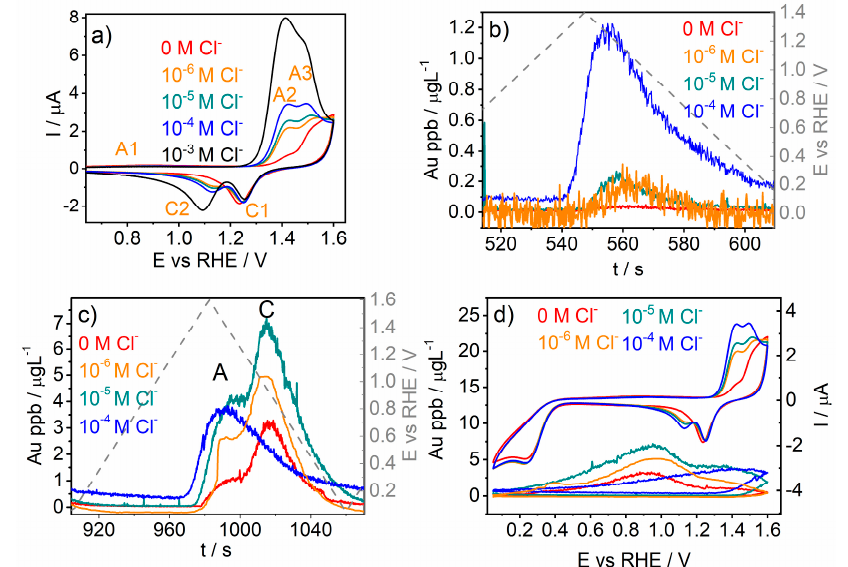
Figure 3. EFC-ICP-MS measurements of Au dissolution from Au polycrystalline disk in the absence ( a , b ) and presence of chlorides ( c , d ) during potentiodynamic cycles (20 mV·s − 1 , 0.05–1.4 or 1.6 V RHE ); ( d ) Simultaneous presentation of Au dissolution profile and current signal during potentiodynamic cycling (20 mV·s − 1 , 0.05–1.6 V RHE ).